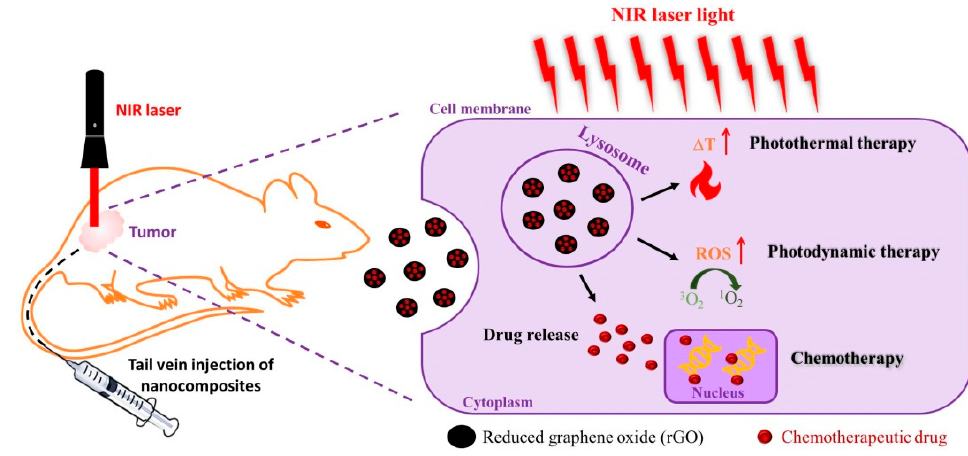
Figure 3. A schematic diagram showing the treatment of subcutaneously implanted cancer cells by combined chemotherapy/phototherapy using reduced graphene oxide (rGO).